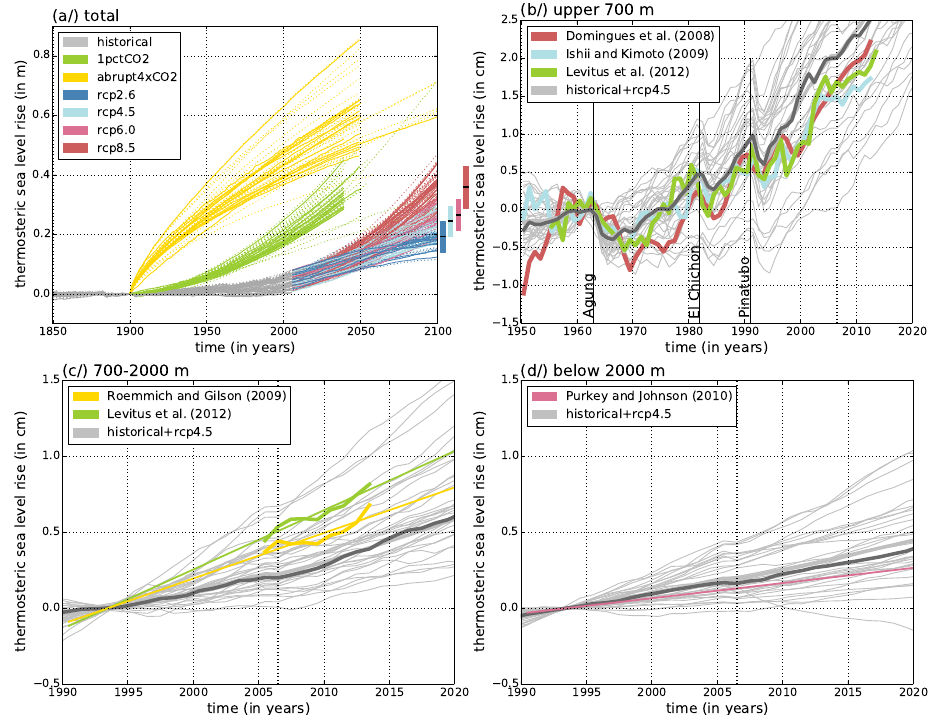
Figure 1. Time series of observed and simulated global mean yearly thSLR (in cm). (a) Simulated thSLR ( zostoga ) relative to year 1900 for seven CMIP5 scenarios: historical (31/47), 1pctCO2 (19/32), abrupt4xCO2 (17/30), rcp2.6 (18/26), rcp4.5 (27/40), rcp6.0 (13/20), rcp8.5 (27/40); the ratio in brackets indicates the number of models of published (solid lines) zostoga and recalculated (dashed lines) zostoga in this study based on simulated temperature and salinity fields. Bars indicate the thSLR of the four RCP scenarios in year 2100 (see also Table 1). (b) Observed contribution to yearly thermosteric sea level of the upper 700m by Domingues et al. (2008), Ishii and Kimoto (2009) and Levitus et al. (2012) relative to year 1961 and corresponding simulated time series of the historical and rcp4.5 scenarios, whereby the solid light (dark) grey lines represent the model mean (median). Observed contribution to yearly thermosteric sea level (in cm) from layers (c) between 700 and 2000m by Levitus et al. (2012) and Roemmich and Gilson (2009) and (d) below 2000m by Purkey and Johnson (2010) relative to year 1993 (indicating the start of the satellite sea level altimetry period). Corresponding simulated time series are shown as in (b)